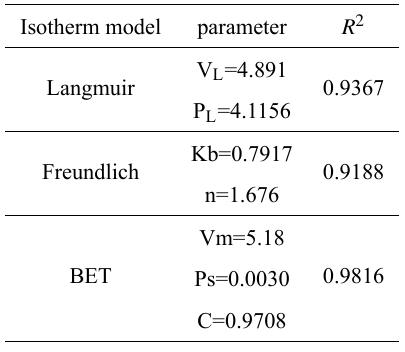
Isothermal adsorption model comparison (Where V L is maximum adsorption capacity, and P L is pressure at 50% of the maximum adsorption capacity, K b represents the binding constant, p represents the gas